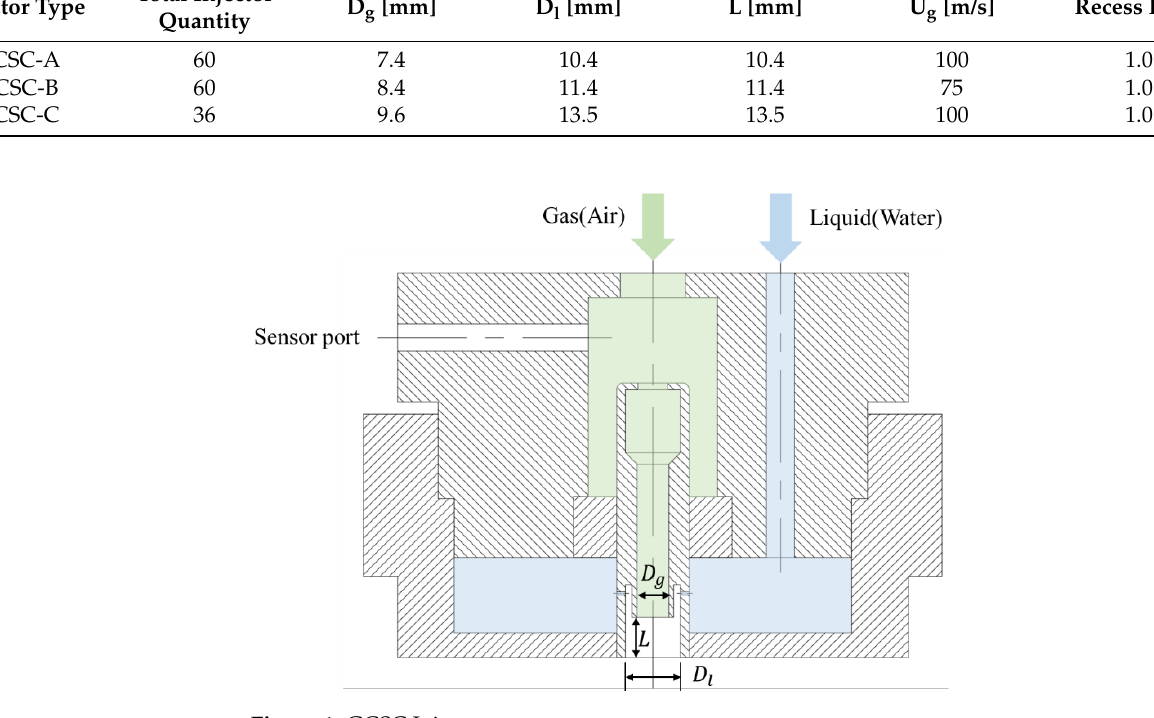
Figure 1. GCSC Injector. Table 2. Experimental